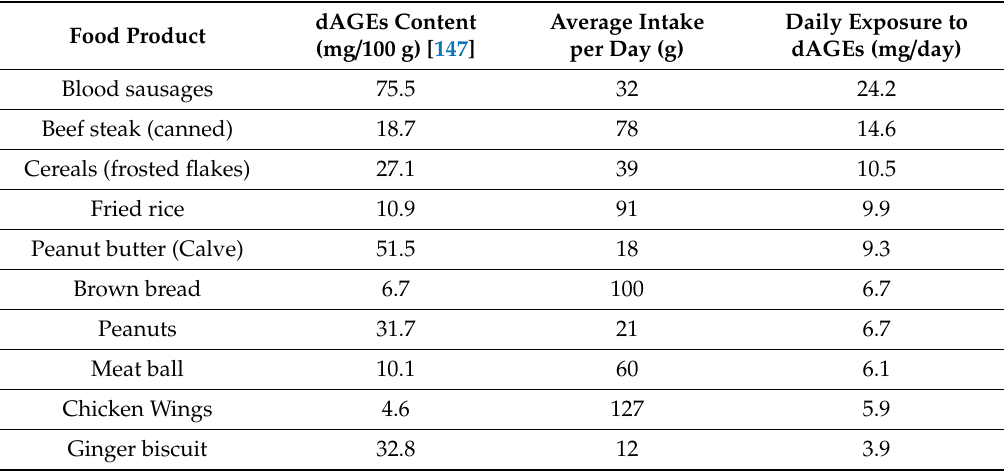
Table 3. Average intake of three dAGEs combined (CML, CEL, and MG-H1) per day per food item of the particular food item users from 19–30 years old in the